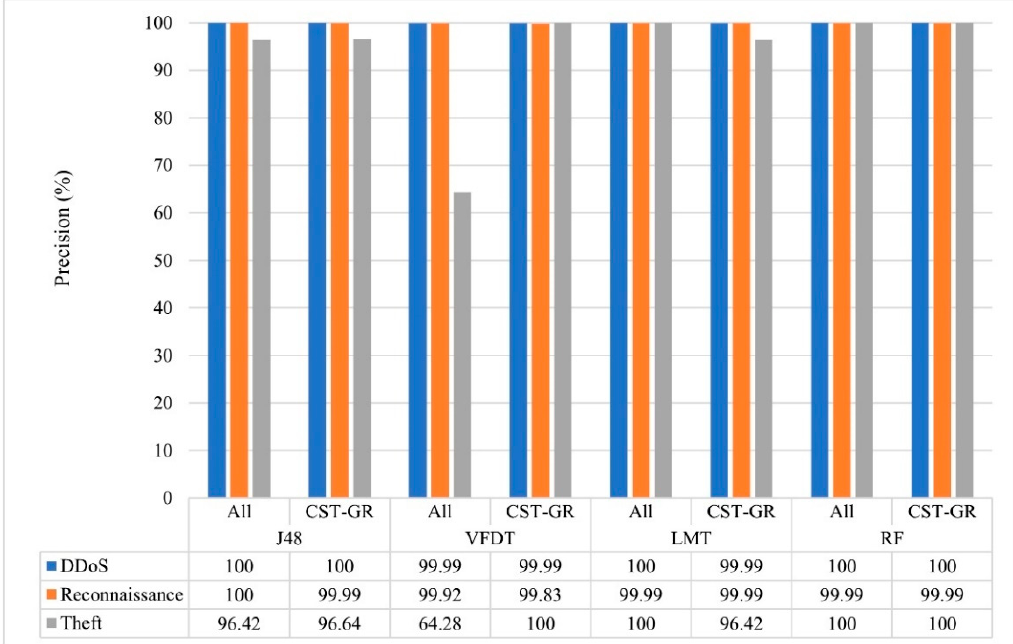
Figure 6. A comparison of precision of J48, VFDT, LMT, and RF between the cases using all features and using CST-GR selected features for each kind of attack.